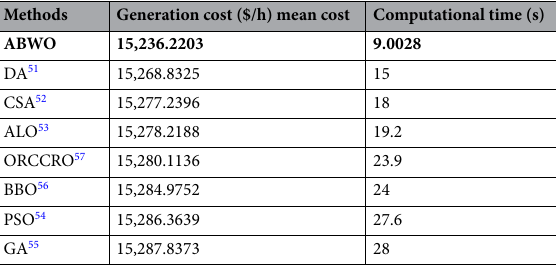
Table 9. Performance analysis of ABWO comparing other approaches case study-III. Significant values are in bold.